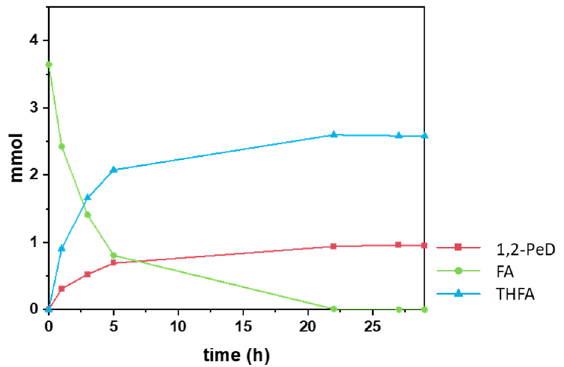
Figure 1. Time–concentration curve for furfuryl alcohol hydrogenation using Ru/PVP as catalyst. Furfural (red curve), furfuryl alcohol (green curve), tetrahydrofurfuryl alcohol (blue curve), acetal (orange curve), 1,2 ‐ pentanediol (pink curve). Reaction conditions: 2 × 10 − 2 mmol of Ru, 4 mmol of FA, 0.5 mmol of dodecane (internal standard), 20 bar of H 2 , 125 °C, 15 mL of 1 ‐ propanol. Quantities of products and reagents were determined by GC using an internal standard technique [29].